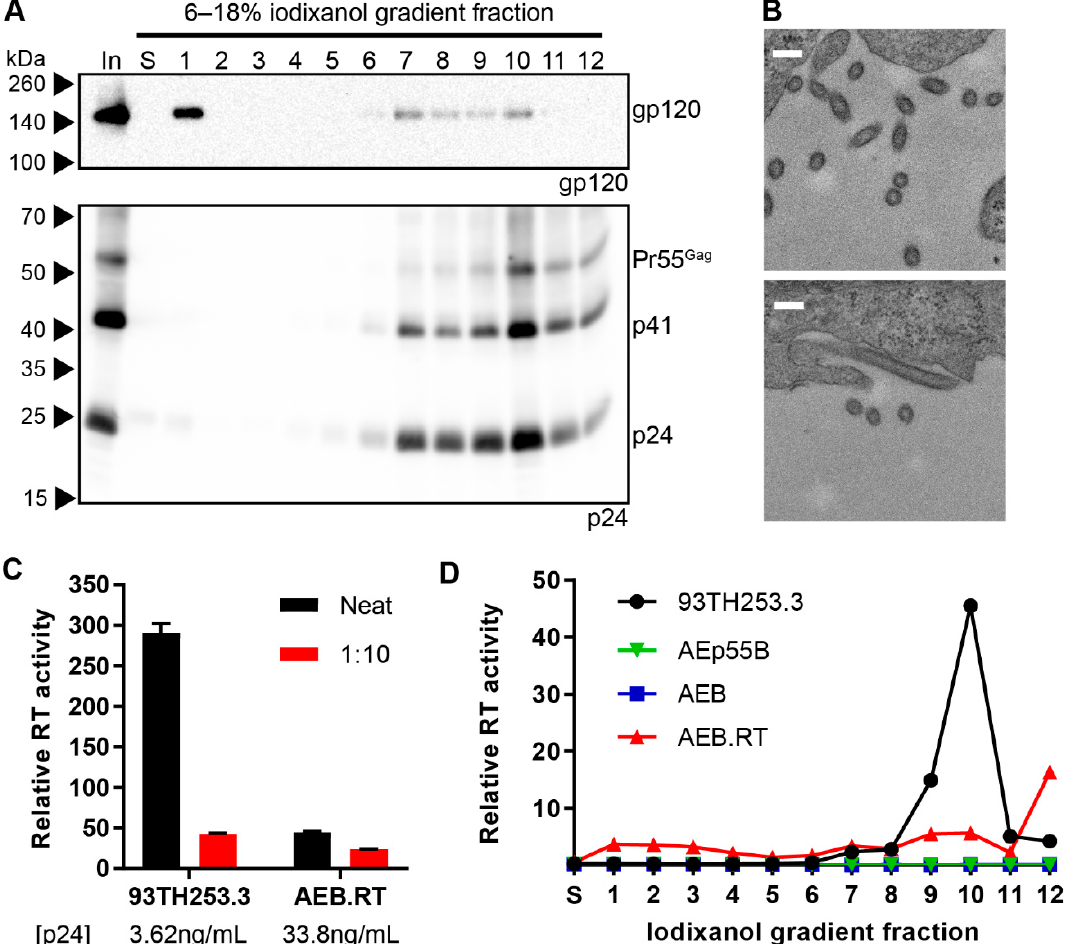
Figure 6. Morphology and RT activity of AEB.RT VLPs. ( A ) AEB.RT VLPs were subjected to rate velocity centrifugation. A sample of the concentrated particles prior to centrifugation (In), the uppermost iodixanol-free fraction of bu ff er created upon application of sample to the gradient (S), and gradient fractions of increasing density (1–12) were resolved by 6–18% SDS-PAGE before Western blotting using anti-gp120 (DV-012, upper panel) and anti-p24 (BC1071, lower panel). The positions of Env and the Gag polyprotein cleavage products are indicated on the right and protein sizes were indicated on the left by Spectra Multicolor Broad Range Protein Ladder. ( B ) Representative images of cells transfected with pCMV-AEB.RT imaged by TEM. Scale bar represents 200 nm. ( C ) The relative RT activity of neat and 1:10 diluted 93TH253.3 virions and AEB.RT VLPs as quantified by a radioactive RT activity assay. The p24 concentration of 93TH253.3 virions and AEB.RT VLPs was determined by p24 ELISA. Values represent the mean and SEM from two independent measurements. ( D ) Relative RT activity was measured in fractions S and 1–12 from rate velocity centrifugation fractions from 93TH253.3, AEp55B, AEB, and AEB.RT particle preparations. Values represent the mean of duplicate